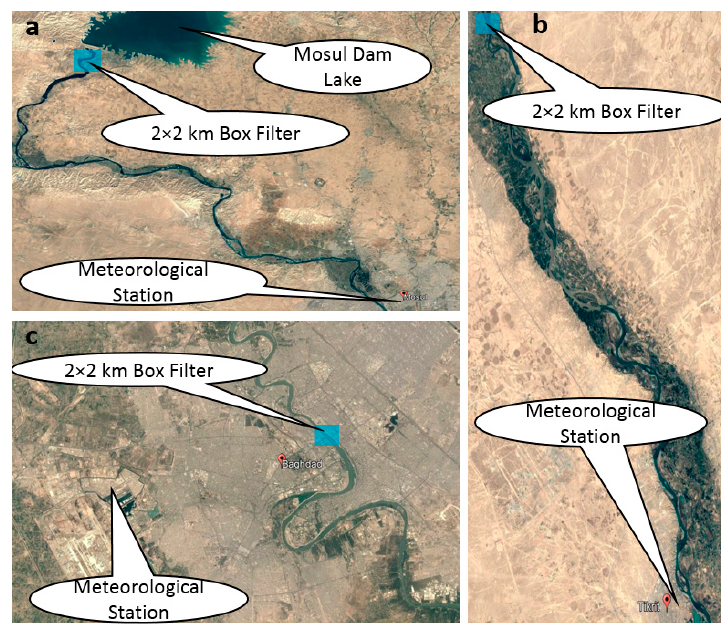
Figure 2. Meteorological stations and box filter regions at ( a ) Mosul; ( b ) Baeji; and ( c ) Baghdad.